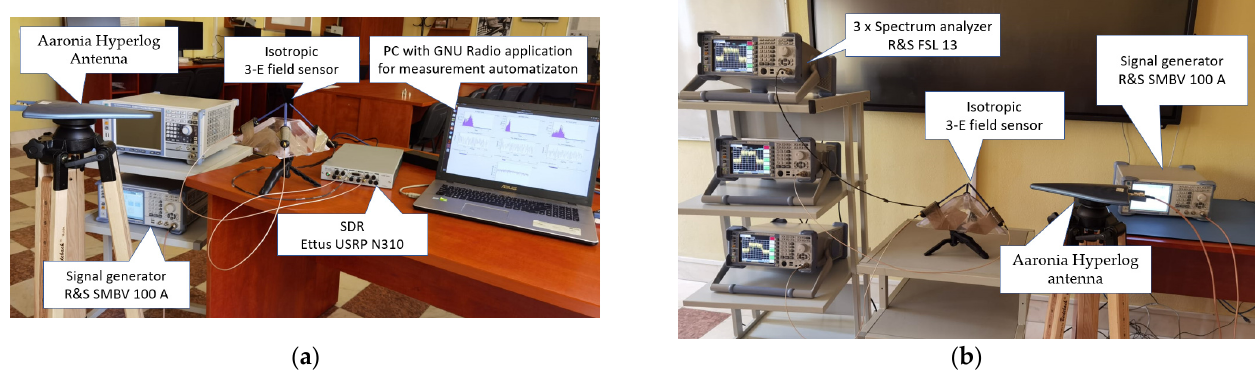
Figure 5. ( a ) SDR-enabled measurement system, ( b ) SA-enabled measurement system.